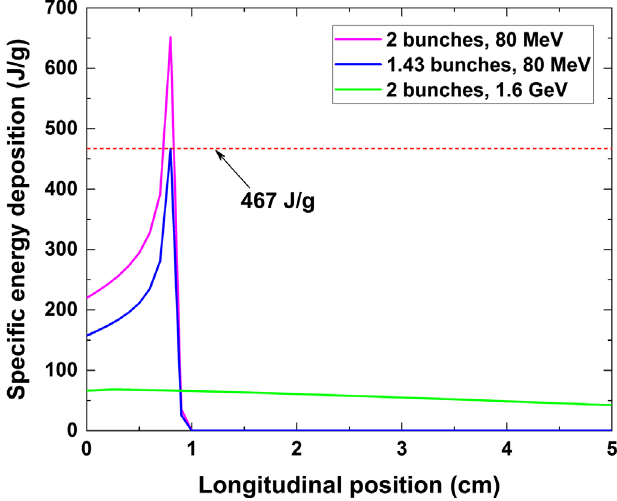
FIG. 23. Specific energy loss for beam impacting the copper at 80 MeV and 1.6 GeV with beam rms size of 1 mm.